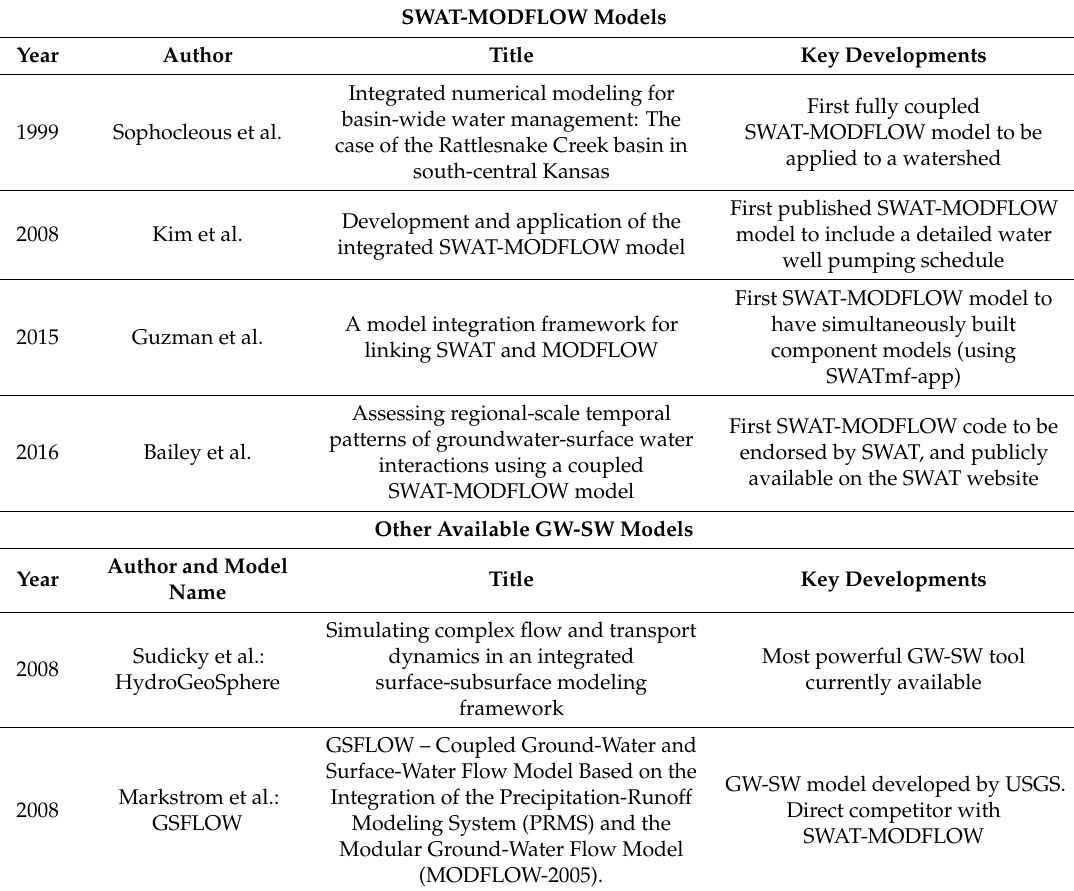
Table A1. List of major developments in SWAT–MODFLOW use, with alternative models listed